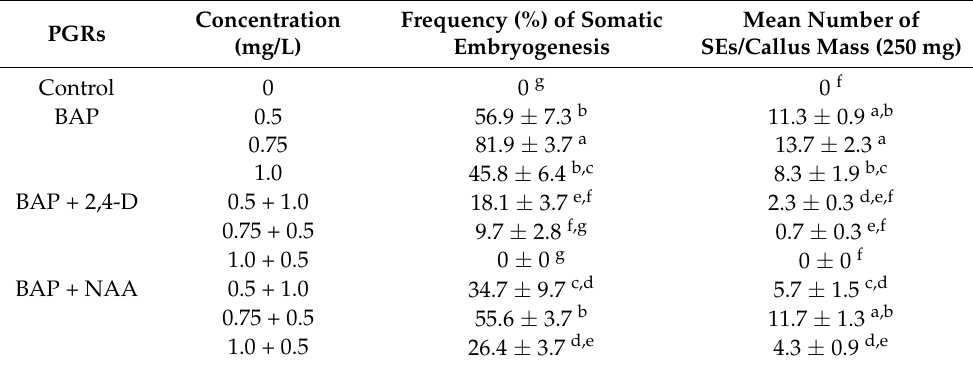
Values indicate means ± standard errors of three replicates of two experiments. Mean values with different superscripts within a column are significantly different from each other as per DMRT at p ≤ 0.05. SEs: Somatic Embryos. The superscripts denote the ranking as per Duncan test i.e ‘a’ represents the best treatment and ‘i’ represents the lowest Table 3. Effect of different concentrations as well as combinations of PGRs on somatic embryogen- esis from hypocotyl callus in D. purpurea.